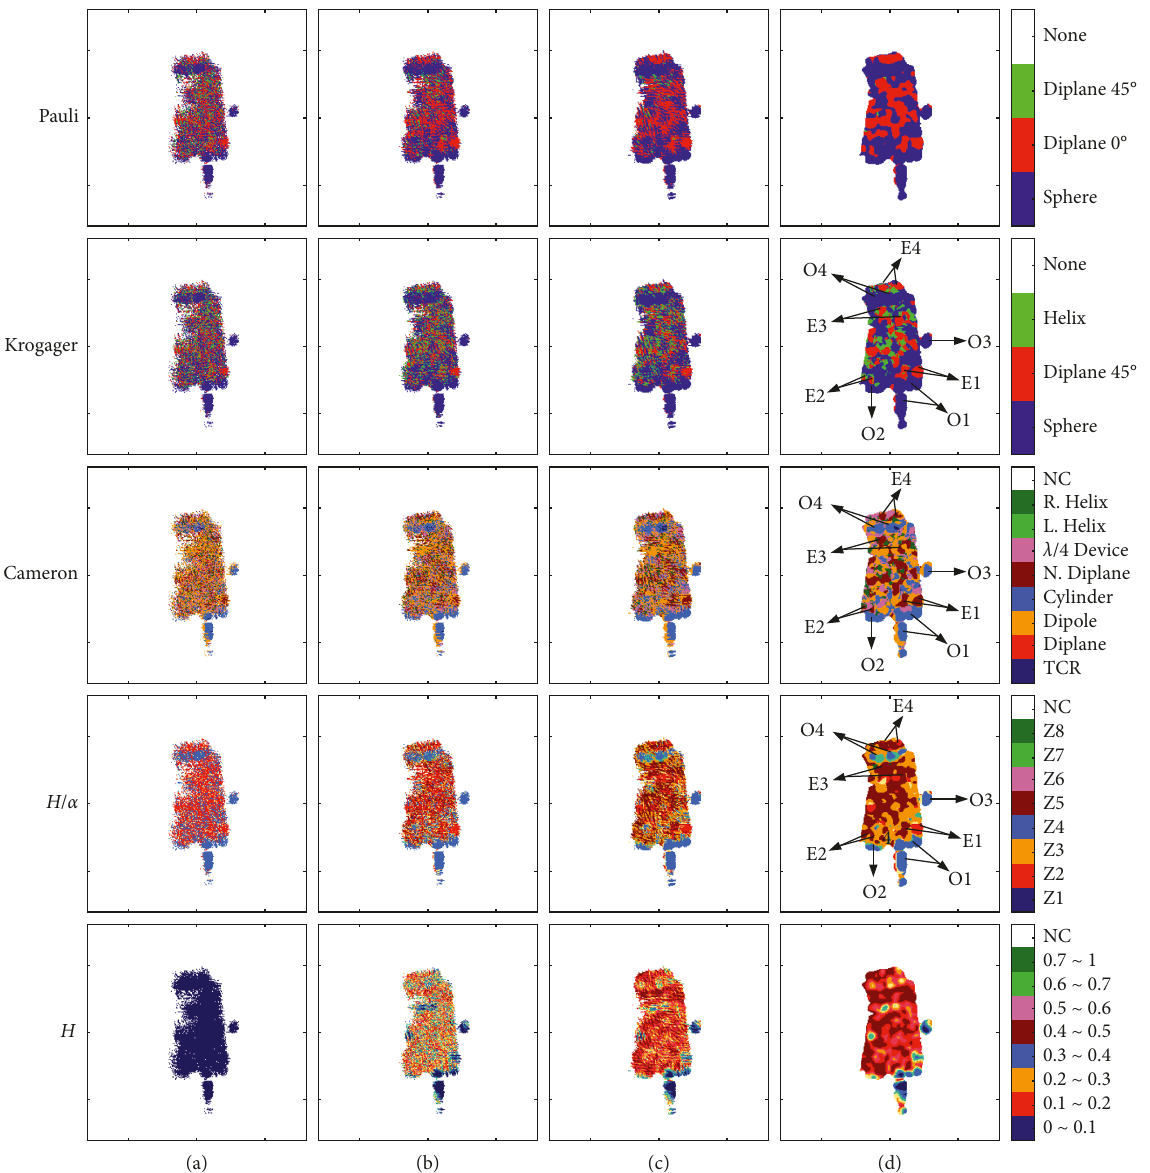
Figure 12: Polarimetric decomposition results for four different processing cases of entire extent (case 1). Subaperture-based imaging with a subaperture number of (b) 3 (case 2), (c) 7 (case 3), and (d) 21 (case